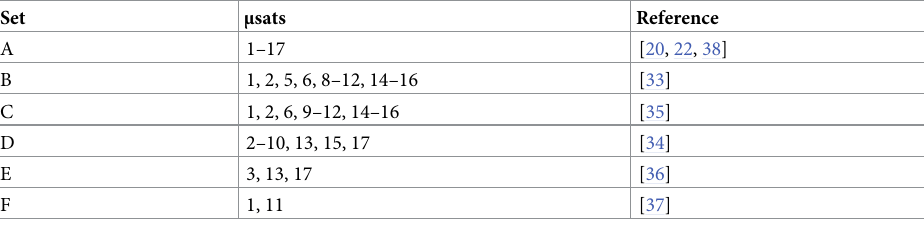
Table 2. Overview of microsatellite sets used.